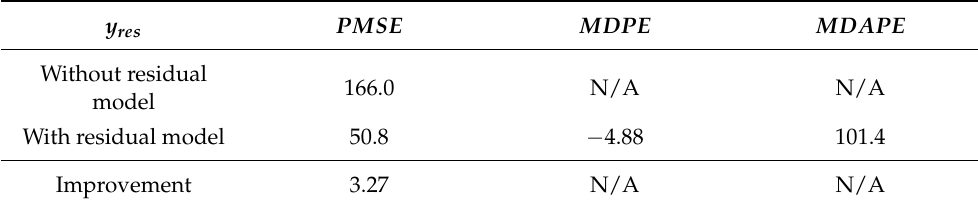
Table 3. Predictive quality measures for y res .